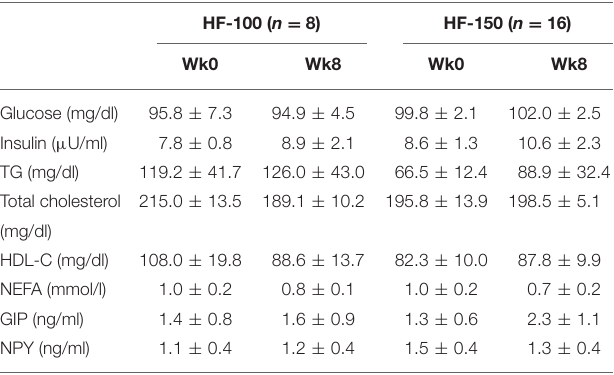
TABLE 3 | Basal concentrations of glucose, insulin, TG, total cholesterol, HDL-C, NEFA, GIP, and NPY at week 0 and at week 8 for HF-100 and HF-150